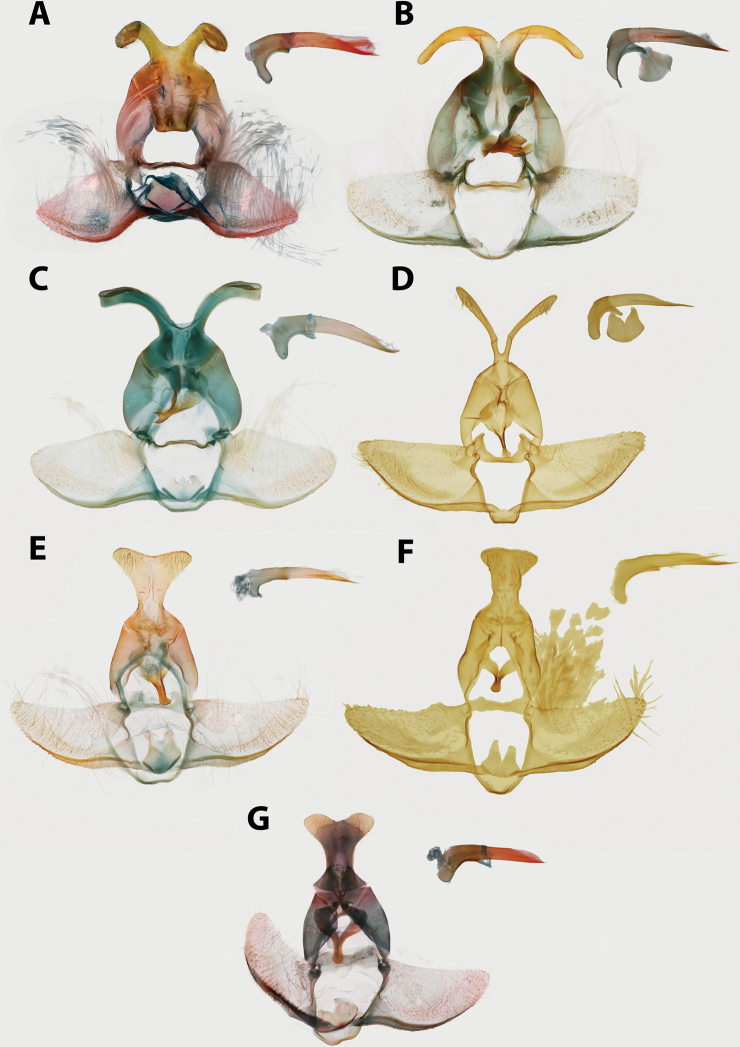
Claduncaria male genitalia. Not to scale. ACla.
maestrana, Cuba. KAA diss. #0150 (VBC) BCla.
ochrochlaena, Dominican Republic. KAA diss. #0120 (CMNH) CCla.
rawlinsana sp. nov. paratype, Dominican Republic. KAA diss. #0121 (CUIC) DCla.
rufochlaena holotype, Jamaica. Razowski diss. #12275 (CMNH) ECla.
mesosignaria, Dominican Republic. KAA diss. #0112 (CMNH) FCla.
minisignaria, Dominican Republic. Razowski diss. #10703 (CMNH) GCla.
taino sp. nov. paratype, Dominican Republic. KAA diss. #0119 (CMNH).